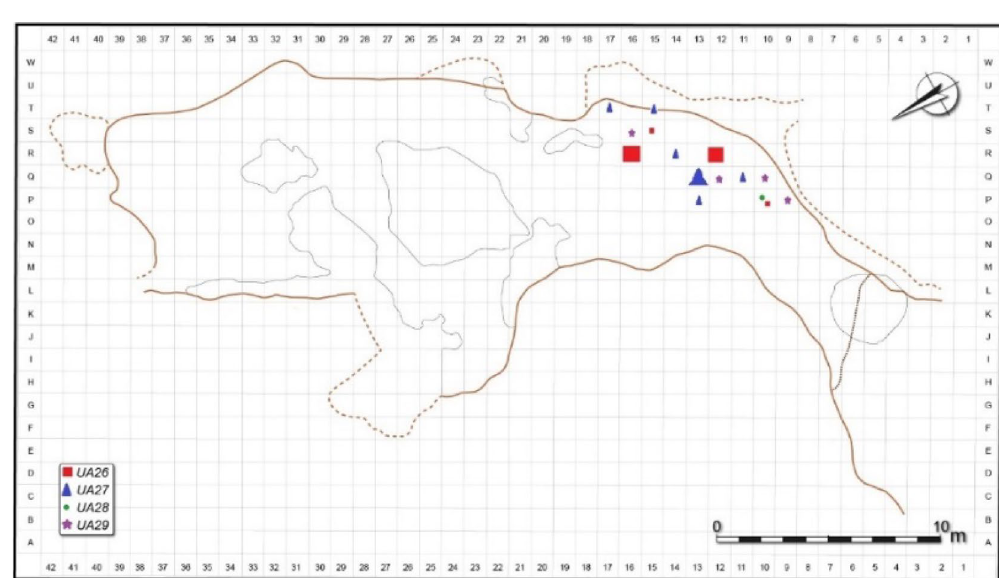
Figure 10. Hearth location in Lazaret Cave from various archaeostratigraphic units, based on 65 . (Courtesy of Prof. Henry de Lumley).